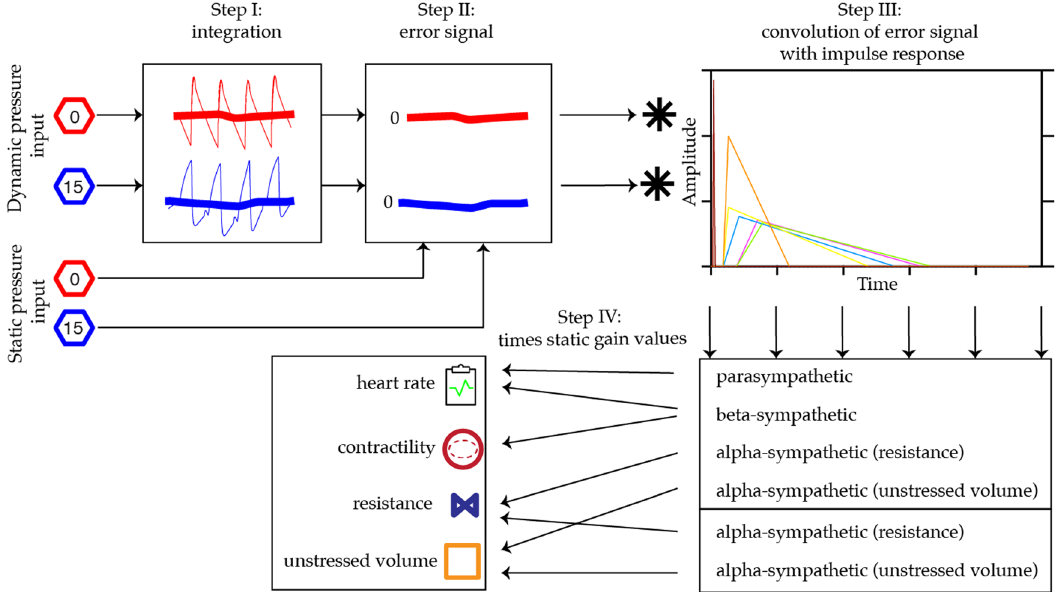
Fig. 5 Schematic overview of the baro- and cardiopulmonary re fl ex control model. Step I; create a mean blood pressure, Step II; create an error signal, Step III convolute the error signal with 6 different impulse responses, and step IV; in fl uence hemodynamic effector sides. See text section 2.3.2, ref. 60 , and model code for more information.